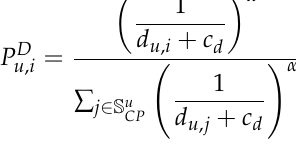
∪ S u = S u ) and candidate spots ( S u RP FP CP